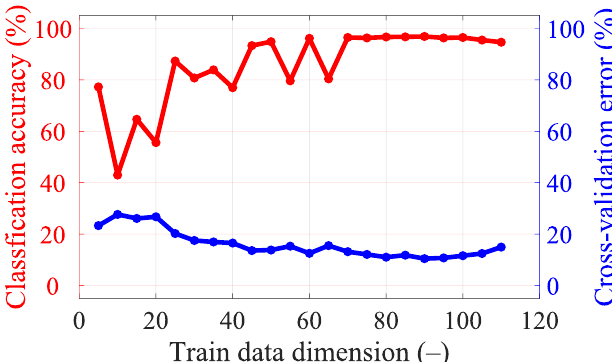
Figure A2. Classification accuracy and cross-validation error for different dimensionality reductions in data for a single frequency point (1 GHz).